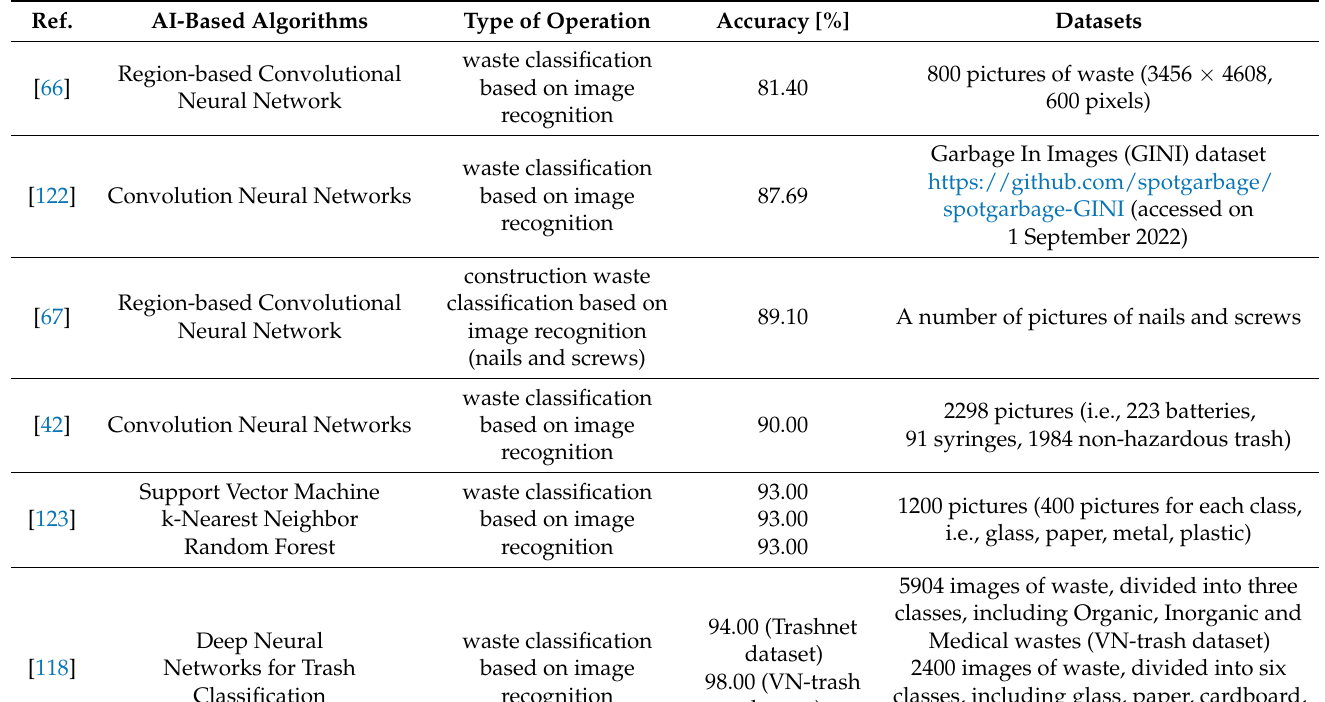
Table 1. Comparison of the Artificial Intelligence-based, in particular Machine Learning-based algorithms in terms of application types and